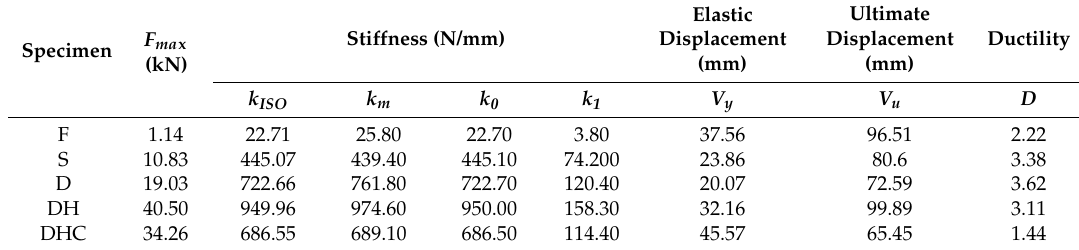
Table 3. Results of the